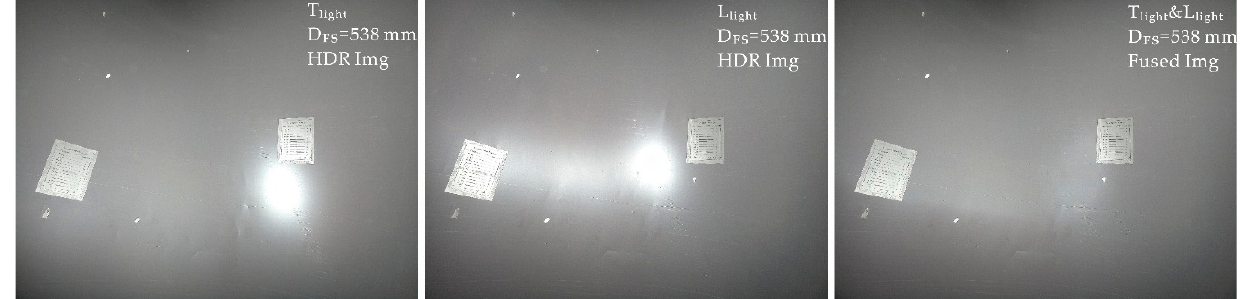
Figure 10. Overexposure suppression process under combined lighting.